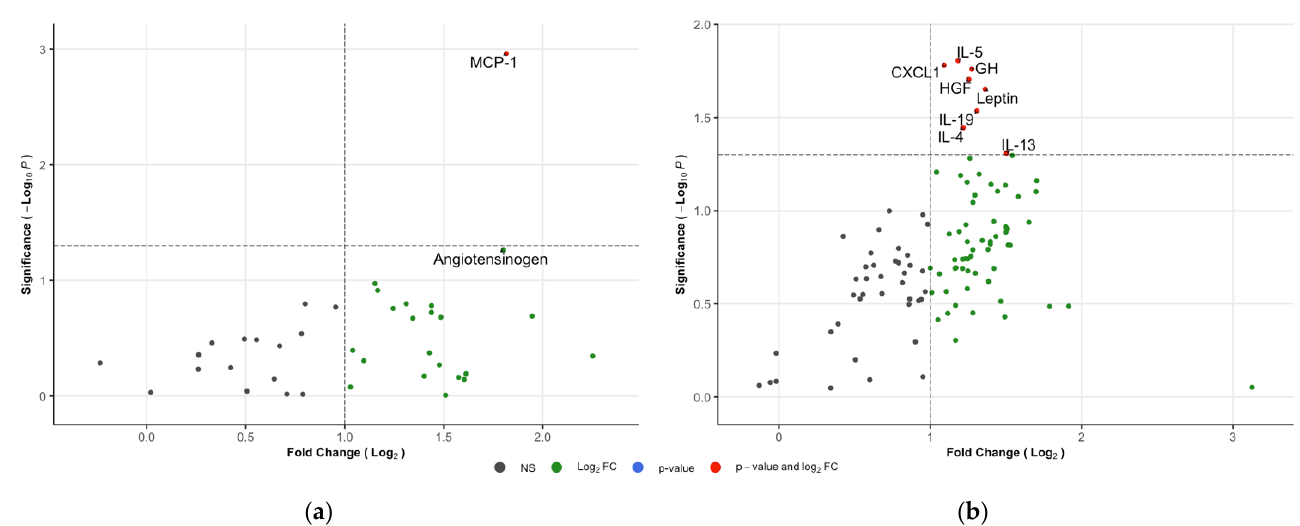
Figure 4. Volcano plots of IgAVwoN vs. HCs: ( a ) Kit K; ( b ) Kit C. The horizontal lines represent the statistical significance cut-off (−log10(0.05)). Vertical lines represent the fold-change cut-off (log2(2.0)).